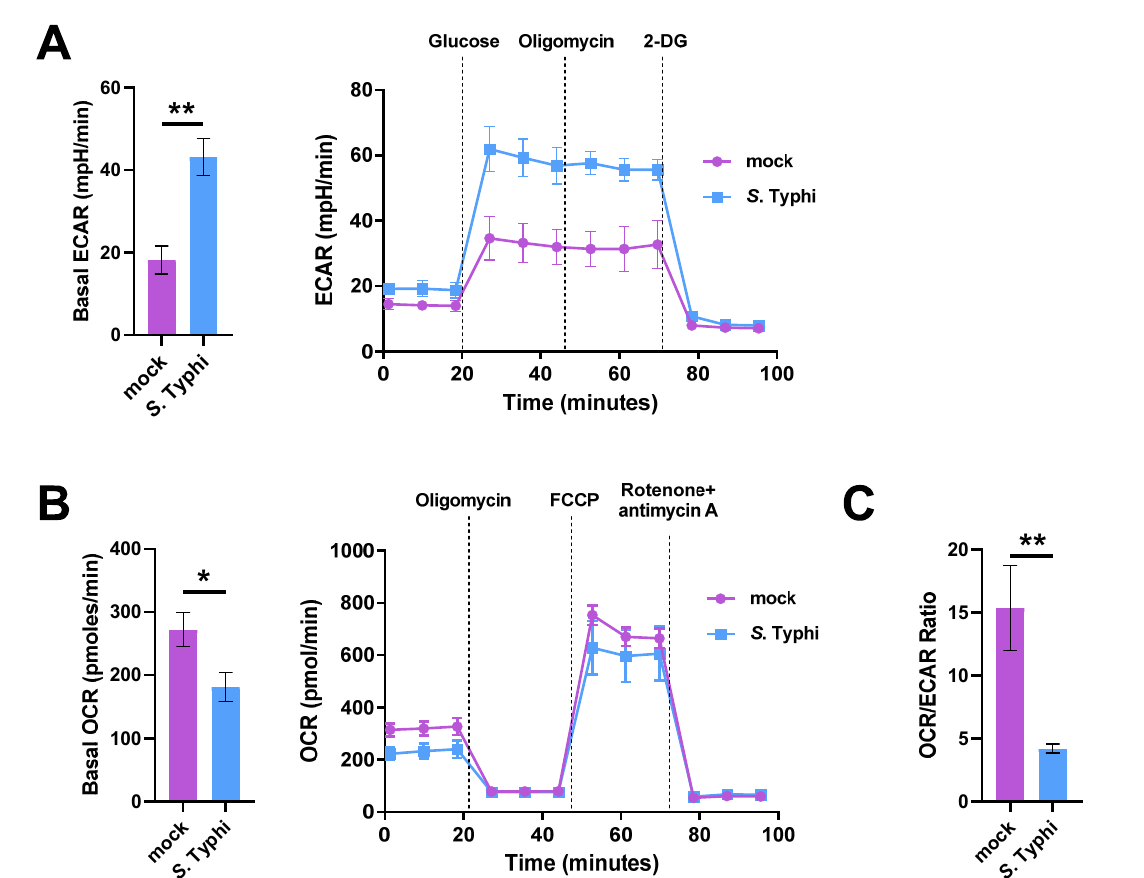
Figure 1. Analysis of glycolytic flux shows Salmonella enterica serovar Typhi ( S. Typhi) infection increases glycolysis while decreasing oxidative phosphorylation (OXPHOS) in human macrophages. ( A ) Extracellular acidification rate (ECAR) of S . Typhi-infected human primary monocyte-derived macrophages (MDMs) vs. mock-infected MDMs (left), and real-time changes in the ECAR (right); 2-deoxy- D -glucose (2-DG). ( B ) Oxygen consumption rate (OCR) of S . Typhi-infected MDMs compared to mock-infected MDMs (left) and real-time changes in the OCR (right); carbonyl cyanide p -(tri-fluromethoxy)phenyl-hydrazone (FCCP). ( C ) OCR/ECAR ratio of mock-infected or S . Typhi-infected MDMs. Data were obtained from three independent experiments and analyzed using Student’s t -test. * p < 0.05; ** p < 0.01.